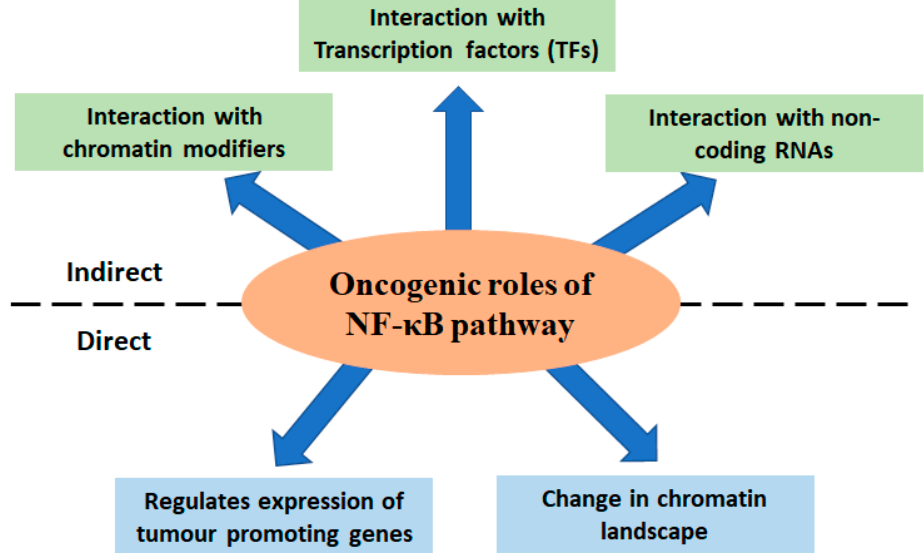
Figure 2. Graphical summary of the mode of activation of oncogenic pathways by NF- κ B signalling cascade via direct (bottom panel) and indirect (upper panel) interaction/regulations of various macromolecular components and factors.